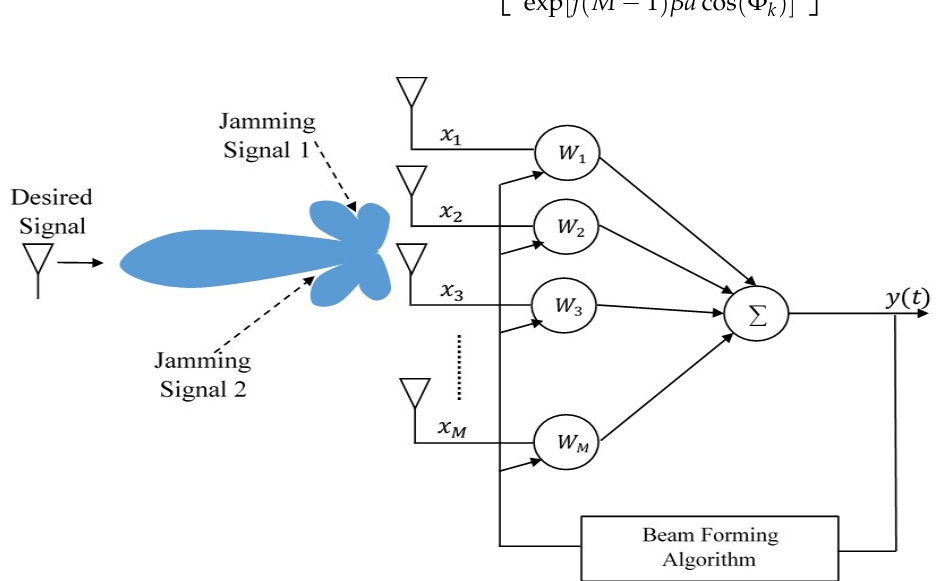
Figure 11. The normalized array factor for 20-element anti-jamming antenna by optimizing the ex- citation amplitude of the array antenna using FKE algorithm.